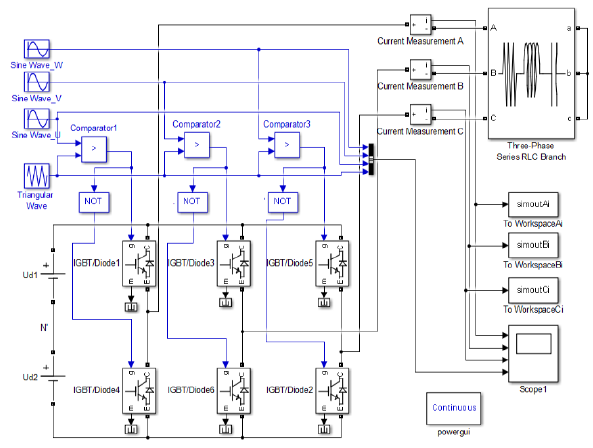
Figure 4. Simulation block diagram of GSC.